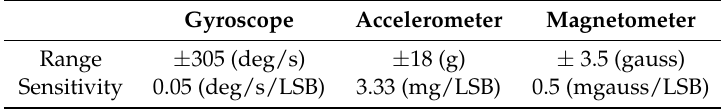
Table 1. The ADIS16405 IMU Specifications [41].